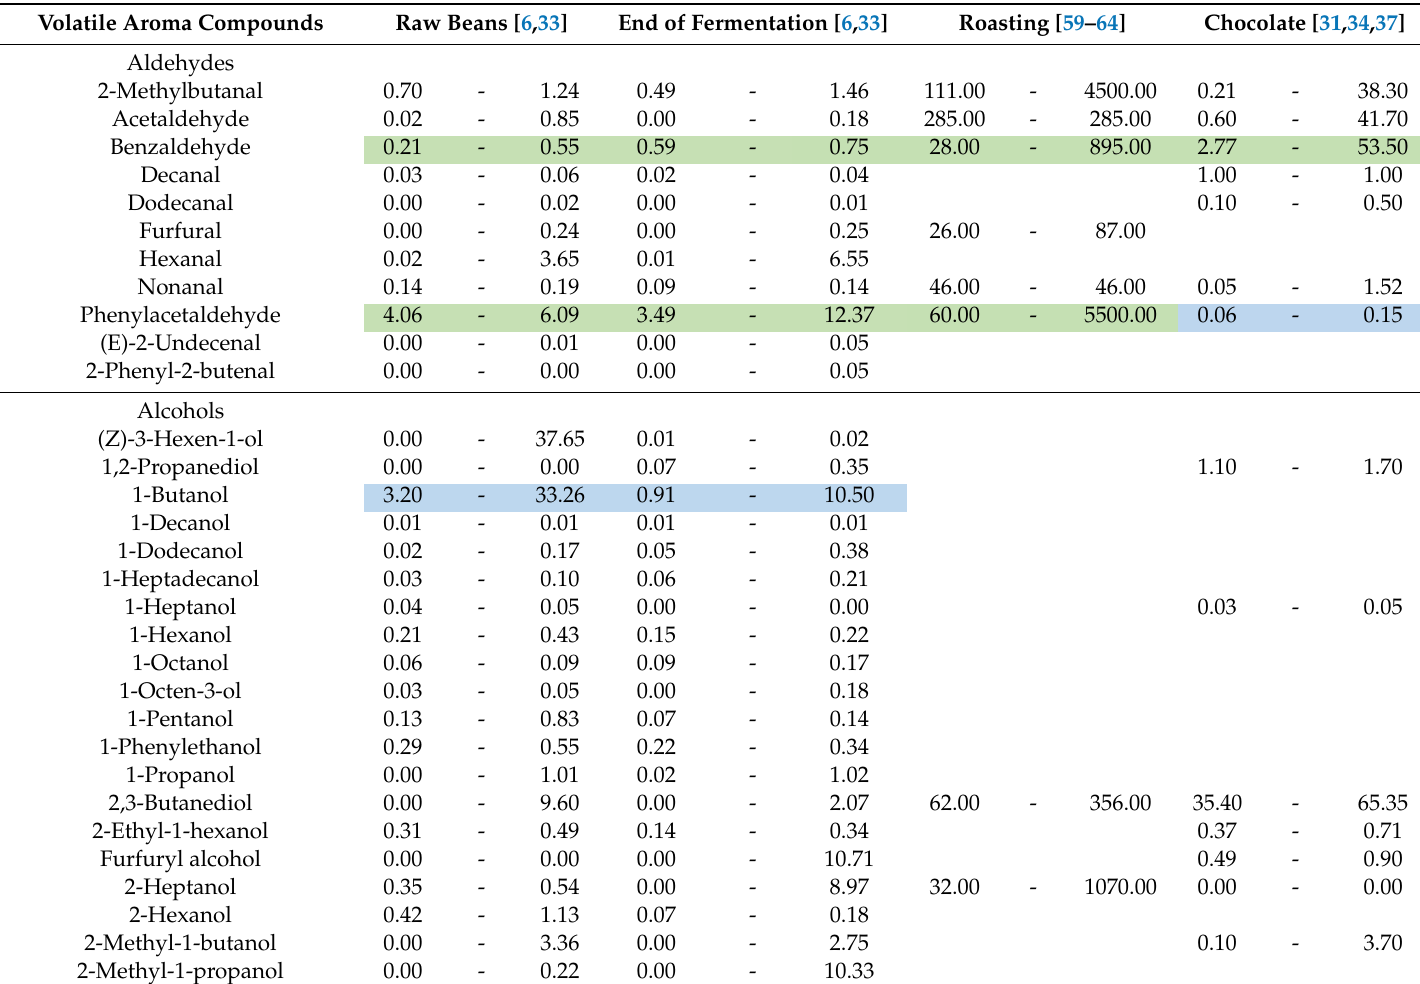
Table 3. Concentration ranges ( µ g / kg) of volatile compounds of raw, fermented, and roasted cocoa beans and